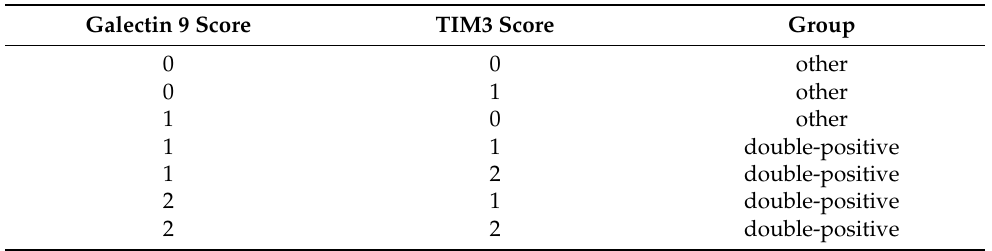
Table 7. Definition of Galectin 9/TIM3 double-positive tumors as any combination not containing negative tumors (score